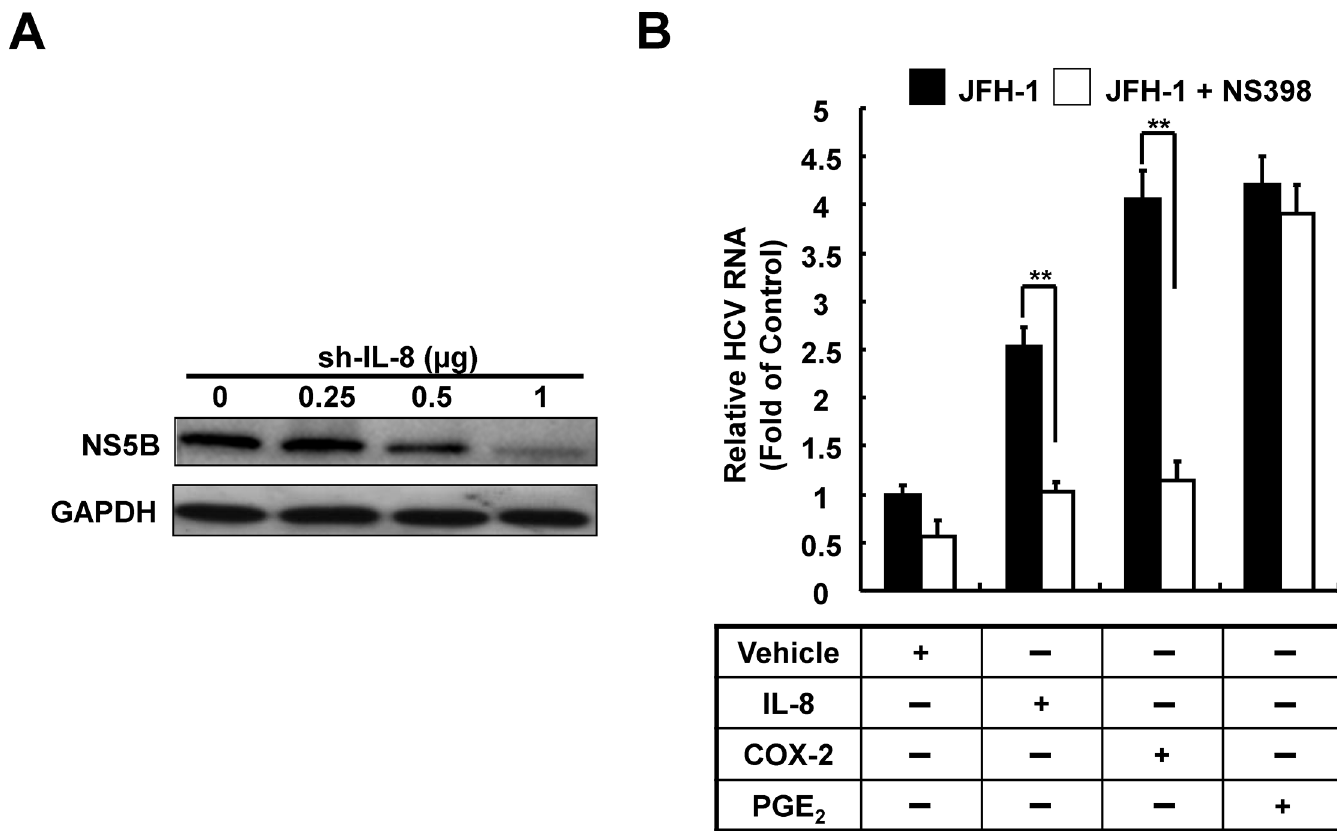
Fig 7. Identification of the roles of IL-8 and COX-2 in HCV replication. (A) Ava5 cells were transfected with IL8-shRNA in a concentration-dependent manner (0 – 2 μ g). After 3 days of incubation, the total cell lysates were extracted and HCV protein synthesis was analyzed by western blotting. GAPDH was used as the equal loading control. (B) Huh7 cells were transfected and treated with pCMV-NS5A-Myc, pCMV-COX-2-Myc, recombinant IL-8 protein, and PGE 2 . The transfected and treated cells were incubated with or without NS398 for 3 days. The relative HCV RNA levels were analyzed using qRT-PCR. The HCV RNA level of JFH-1-infected Huh7 cells was defined as 1. Data shown are mean ± SE; n = 3. * p < 0.05. ** p <